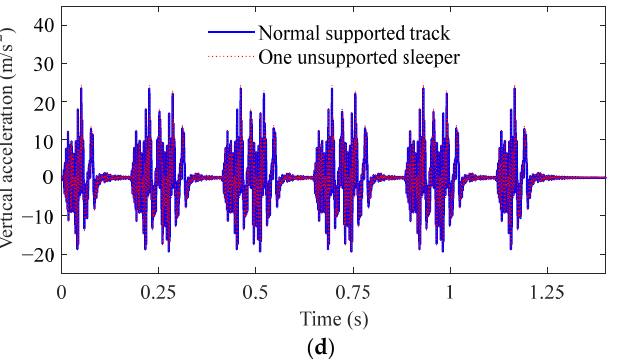
Figure 15. Dynamic responses under the unilateral unsupported sleepers at point A: ( a ) displacement of the left-side rail, ( b ) displacement of the right-side rail, ( c ) acceleration of the left-side rail, and ( d ) acceleration of the right-side rail.